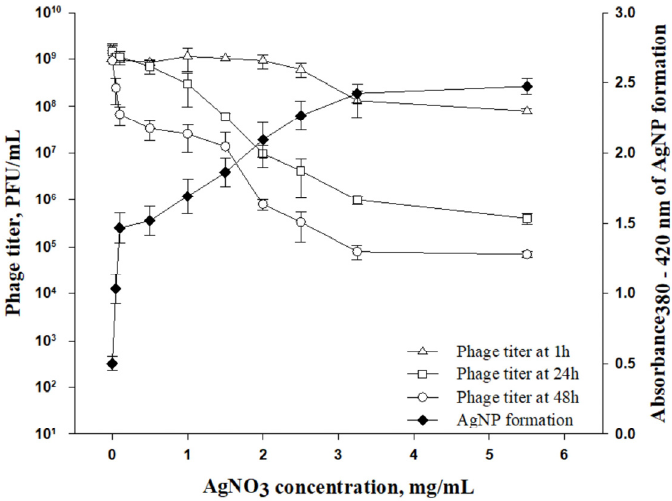
Figure 4. Effect of AgNO 3 concentration and incubation time on infectivity of phages incorporated in alginate–silver coating.